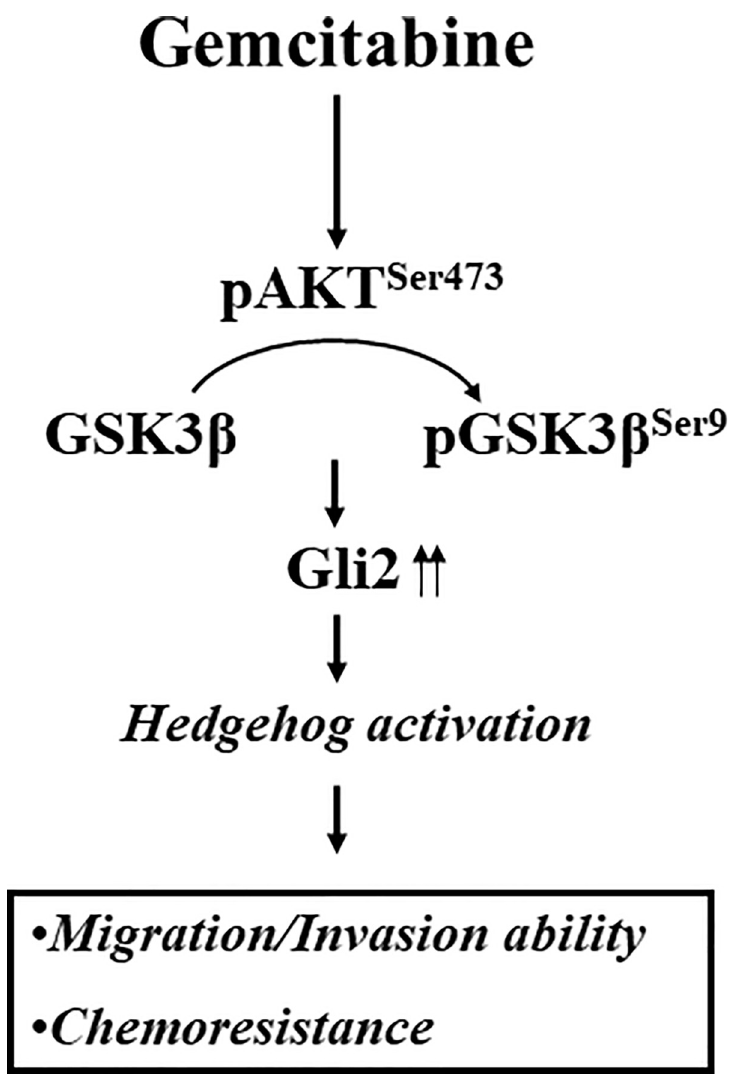
Fig 5. Scheme illustrates the involvement of Gli2-dependent pathway in gemcitabine resistant UC cells. The possible mechanisms identified from the in vitro results of present study were summarized in this cartoon graph. Besides the involvement of aberrant gemcitabine metabolism, gemcitabine can activate AKT Ser473 phosphorylation to inactivate GSK3 β kinase by phosphorylating its Ser9 residue. The inactivated GSK3 β leads to stabilize Gli2 proteins to induce its downstream target genes expressions, which promotes migration/invasion abilities and resistance to